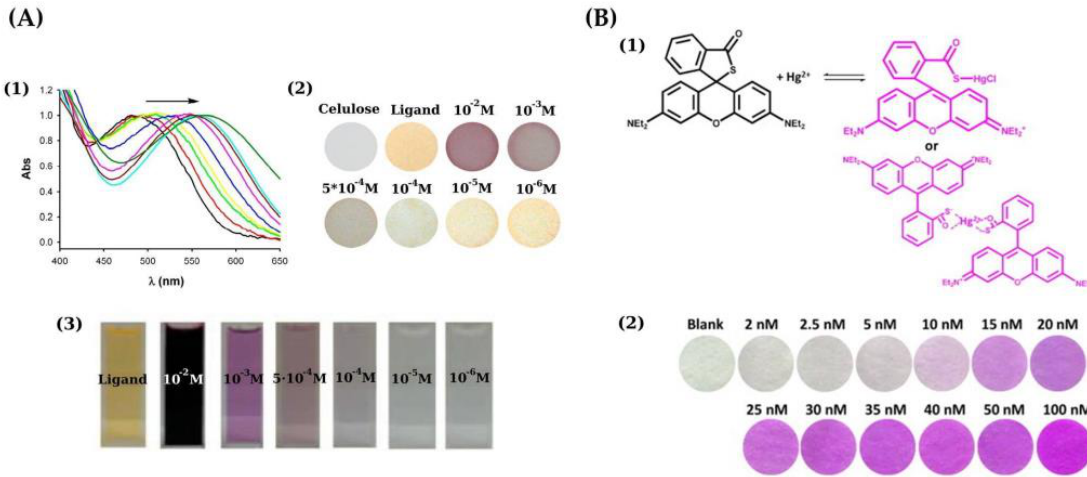
Figure 3. ( A ) (1) Normalized reflectance UV-Vis spectra of Hg(II) in acetonitrile upon dipping cellulose papers into solutions containing increasing concentrations; a bis(ferrocenyl) azine was used as chromogenic reagent; (2) naked-eye detection of Hg(II) using the paper-based sensor; (3) color of acetonitrile-water solutions of the chemosensor in the presence of Hg(II) at different concentration [42]. ( B ) (1) Reaction between rhodamine B thiolactone and Hg(II) to yield a purple red product; (2) paper-based sensors for Hg(II) showing the change from white to a purple-red color; a 10 nM Hg concentration can be detected with the naked eye [43]. Reproduced with permission of Elsevier [43].